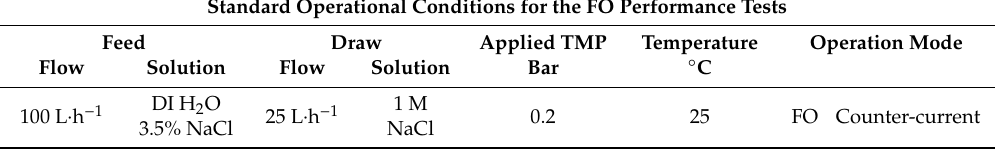
Table 1. Operational conditions for the standard forward osmosis (FO) tests. During the FO performance tests, only one of the listed testing parameters was modified while other parameters were kept constant. TMP, transmembrane pressure; DI, deionized.